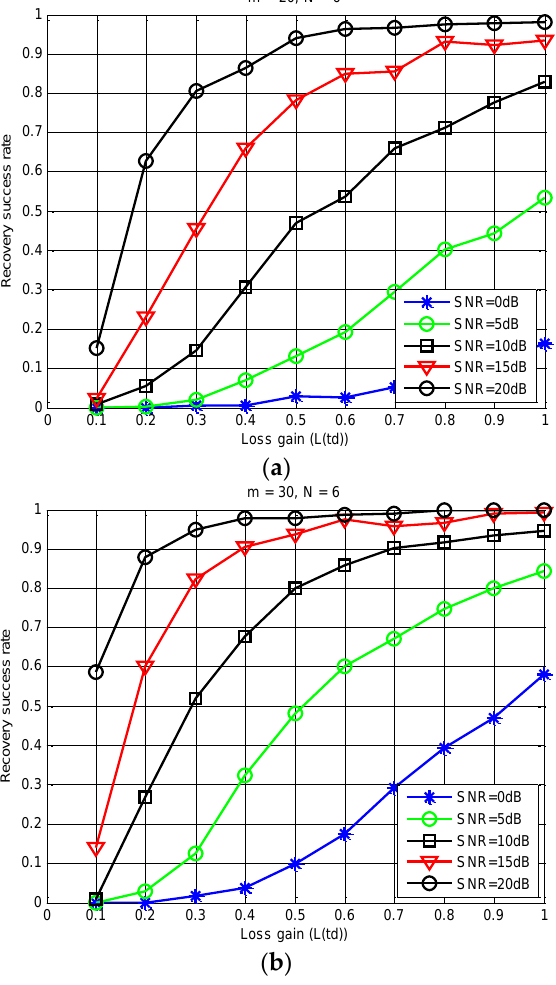
Figure 13. Recovery success rate versus the loss gain. ( a ) m = 20, N = 6; ( b ) m = 30, N = 6.